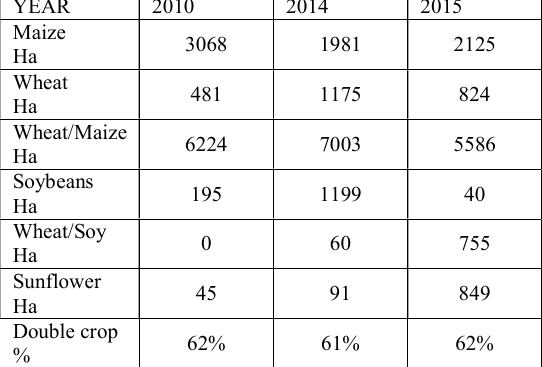
Table 2. Fauresmith pivot irrigated field information for